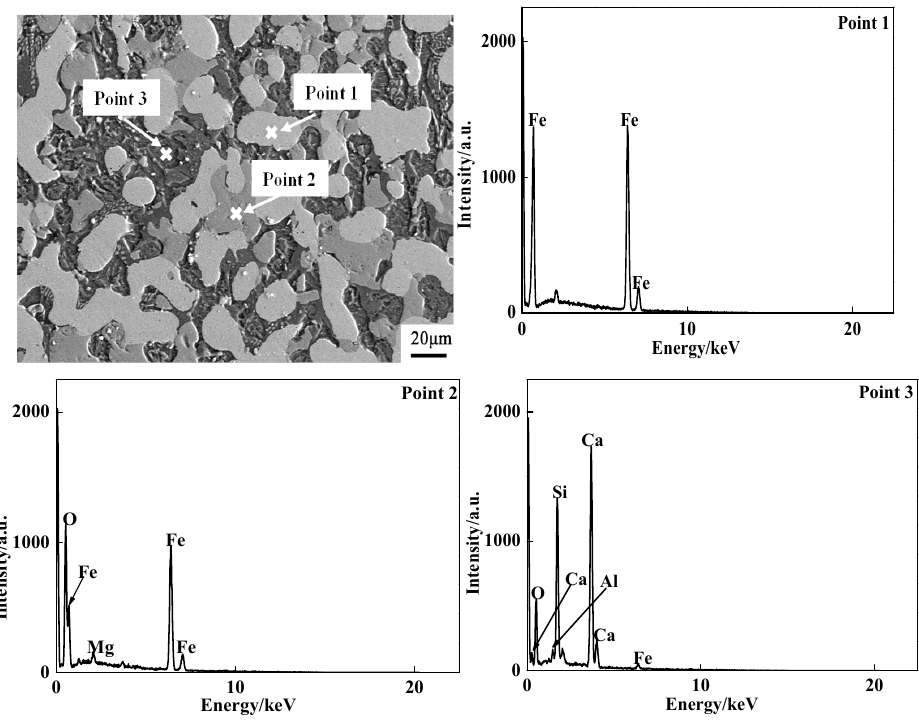
Figure 15. SEM image and EDS analysis of 2.0 wt% MgO sinter during T S .